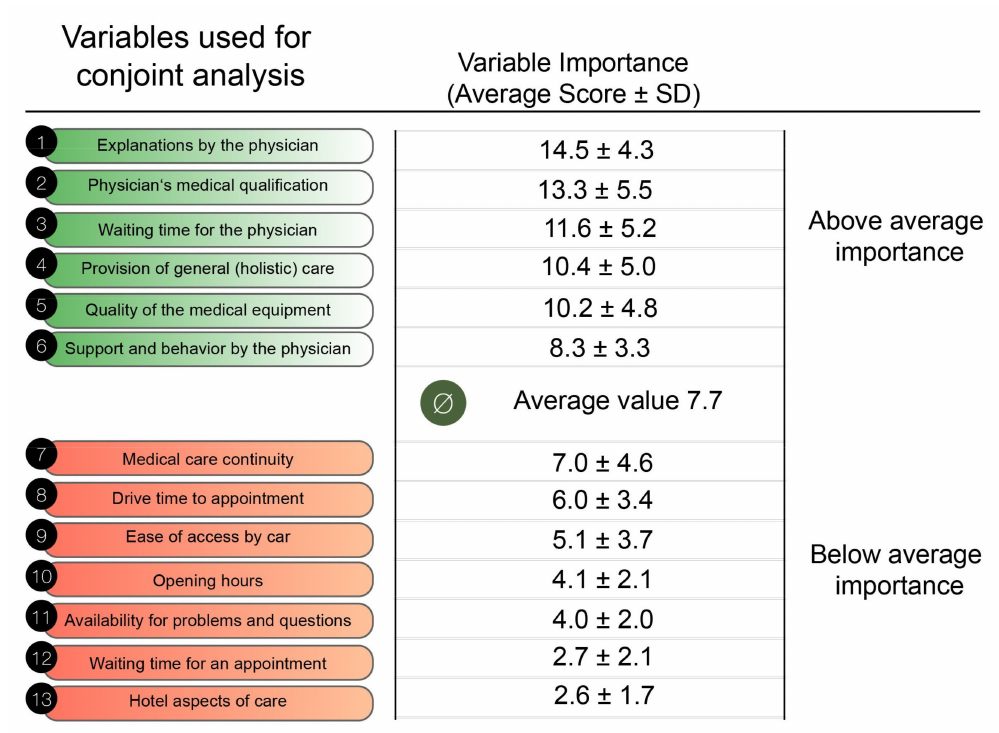
Figure 3. Overview of the importance assigned to each of the 13 categories used for conjoint analysis by the study participants.